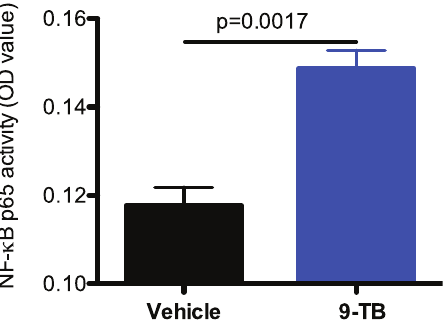
Figure 2. 9-TB enhances NF- k B activation in saline-treated CC10- CA IKK b Tg + mice. NF- k B activity in 9-TB- and saline-treated CC10- CA IKK b Tg + mice was measured by using the NF- k B p65 ELISA in nuclear proteins extracted from mouse lungs (n=4 mice per group). Data are expressed as means 6 SEM.